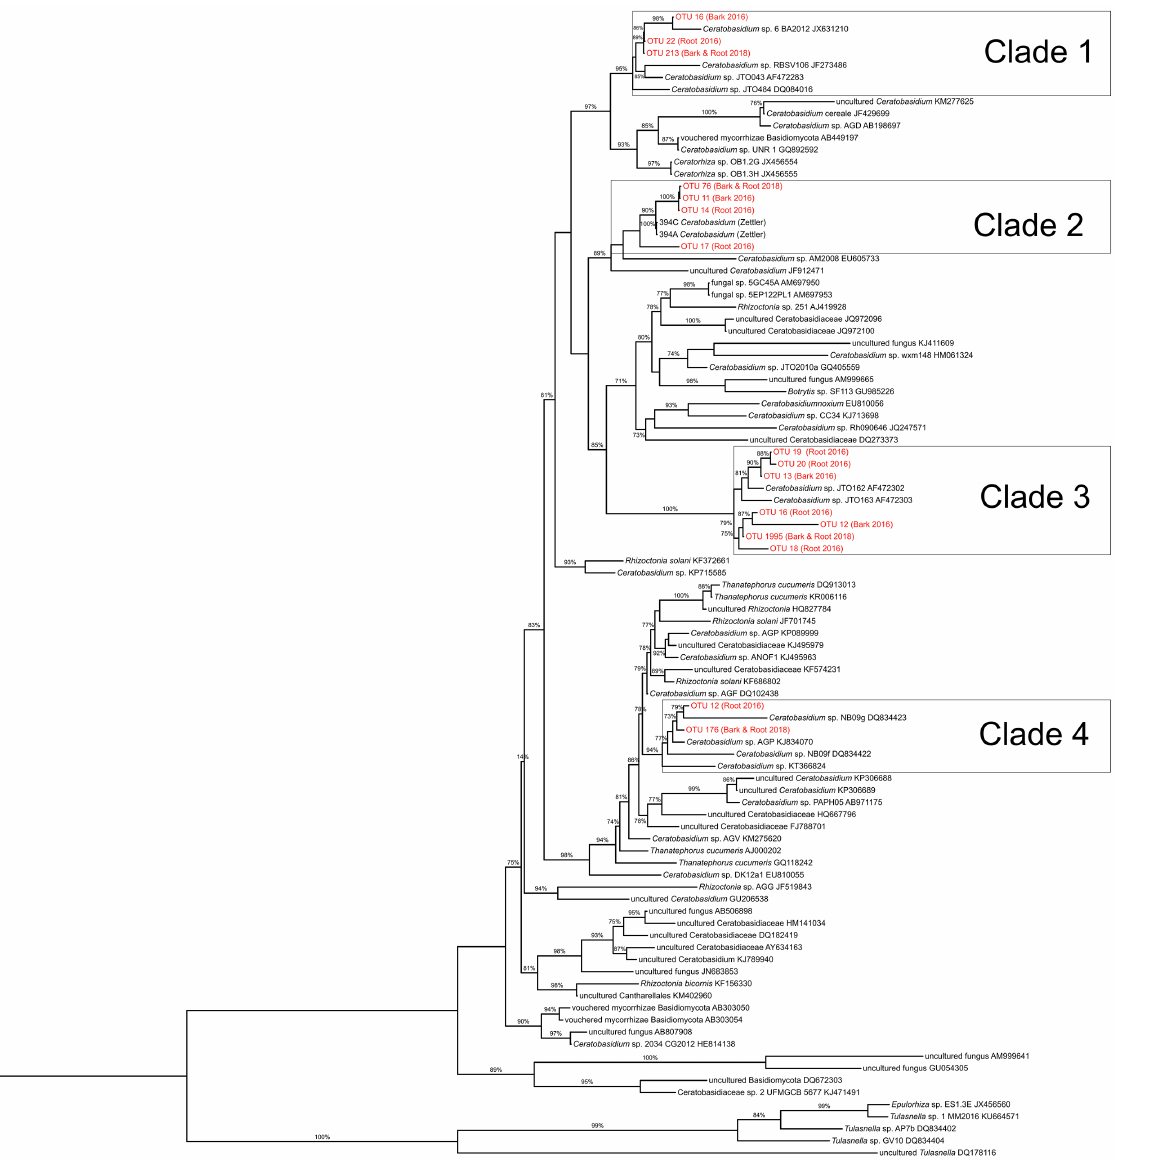
FIGURE 3 Maximum likelihood phylogeny of putative Ceratobasidiaceae species based on ITS data set of 95 taxa using FastTree constructed with default parameters. A cultured Tulasnella was used as an outgroup taxon. Bootstrap support values above 70% are reported. Sequences generated during this study are indicated in